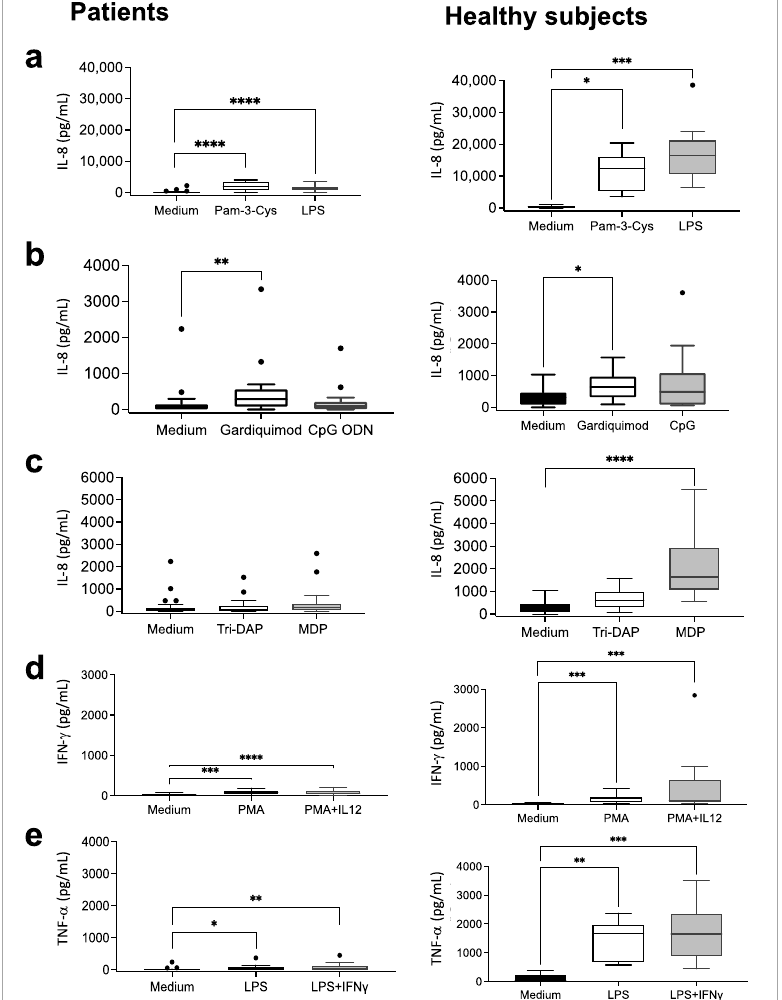
Figure 2. The functionality of innate and adaptive immune receptors in critically ill COVID-19 patients and healthy subjects at admission. Whole blood diluted 1:1 with culture medium was stimulated with specific ligands of innate immunity receptors ( a – c ): TLR2 (Pam-3-Cys, 2 µg/mL), TLR4 (LPS, 100 ng/mL), TLR7/8 (Gardiquimod, 5 µg/mL), TLR9 (CpG ODN, 10 µg/mL), NOD1 (Tri-DAP, 10 µg/mL), and NOD2 (MDP, 10 µg/mL), as well as specific ligands of cytokine receptors ( d , e ): IFN-γR (LPS, 100 ng/mL and rhIFN-γ, 1000 U/mL) and IL-12R (PMA, 25 ng/mL and rhIL-12, 25 ng/mL). Plasma levels of IL-8, TNF-α, and IFN-γ were measured as readout of ligand-dependent responses, by ELISA. Box plots indicate medians and quartiles. * p < 0.05, ** p < 0.01, *** p < 0.001, **** p < 0.0001.